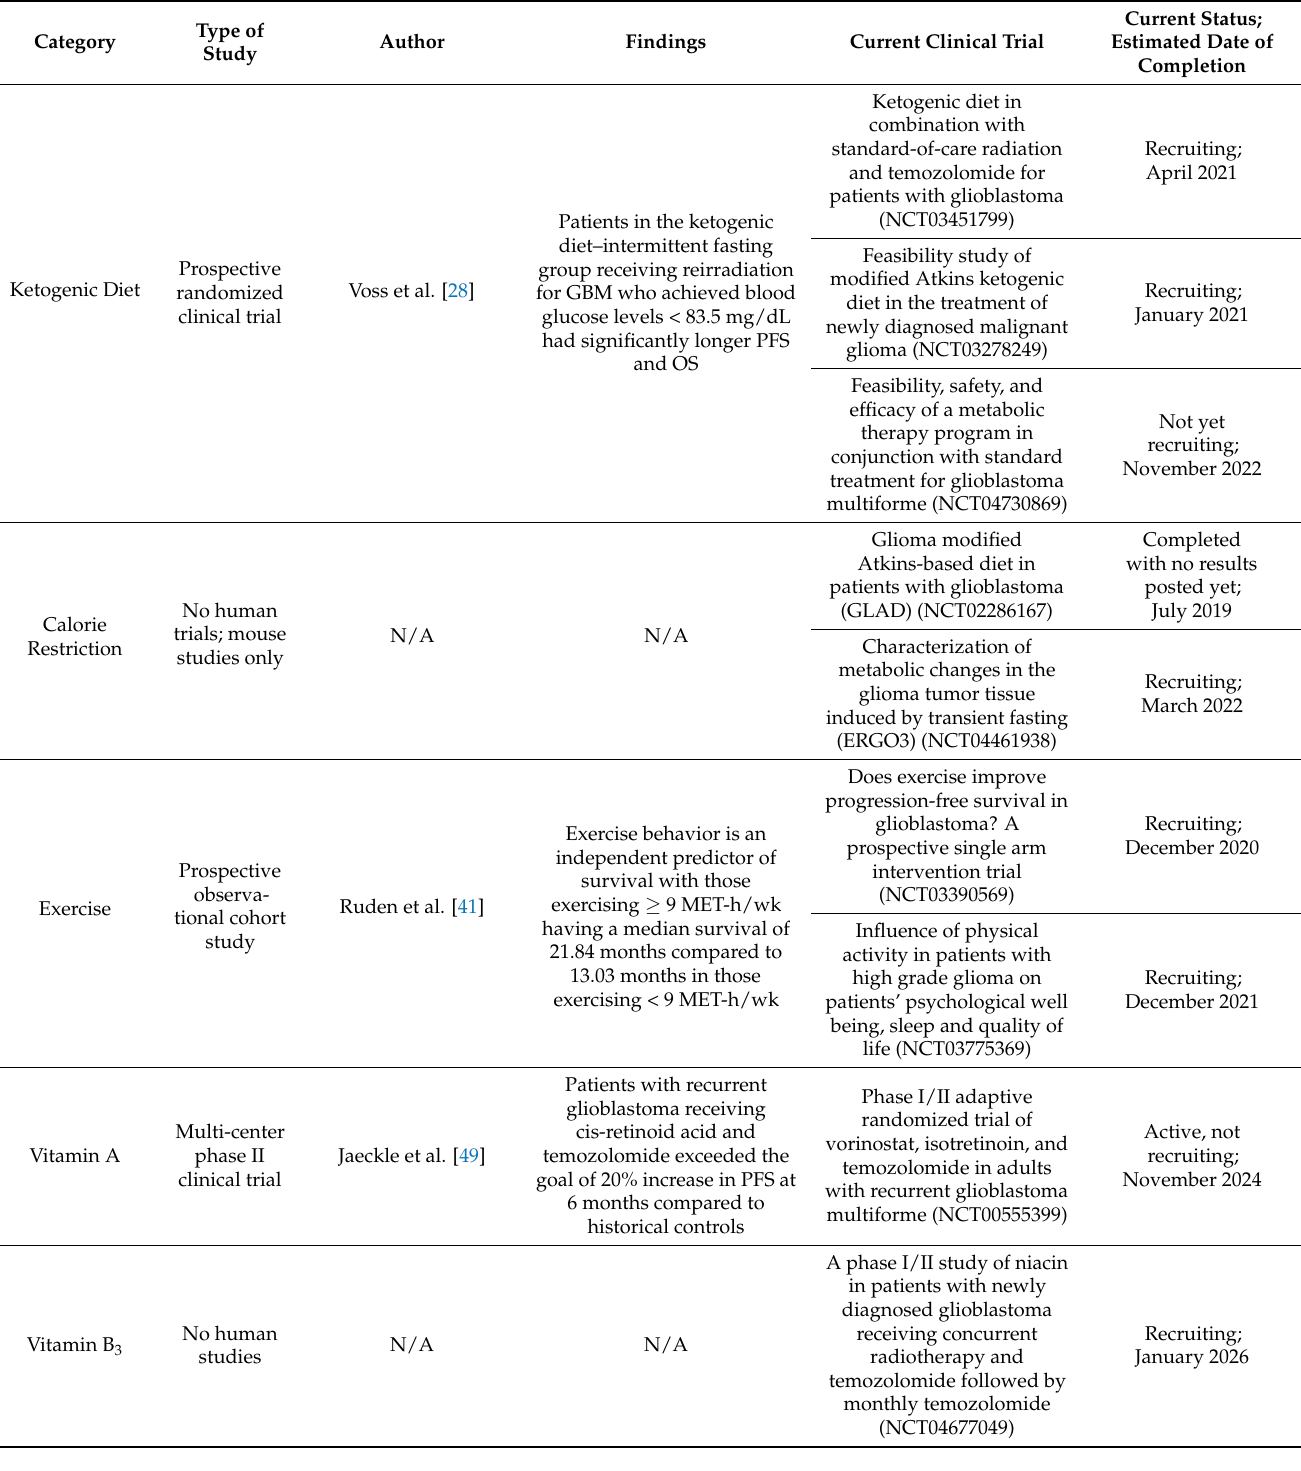
Table 1. Highest level of evidence in human studies of lifestyle modification on glioblastoma